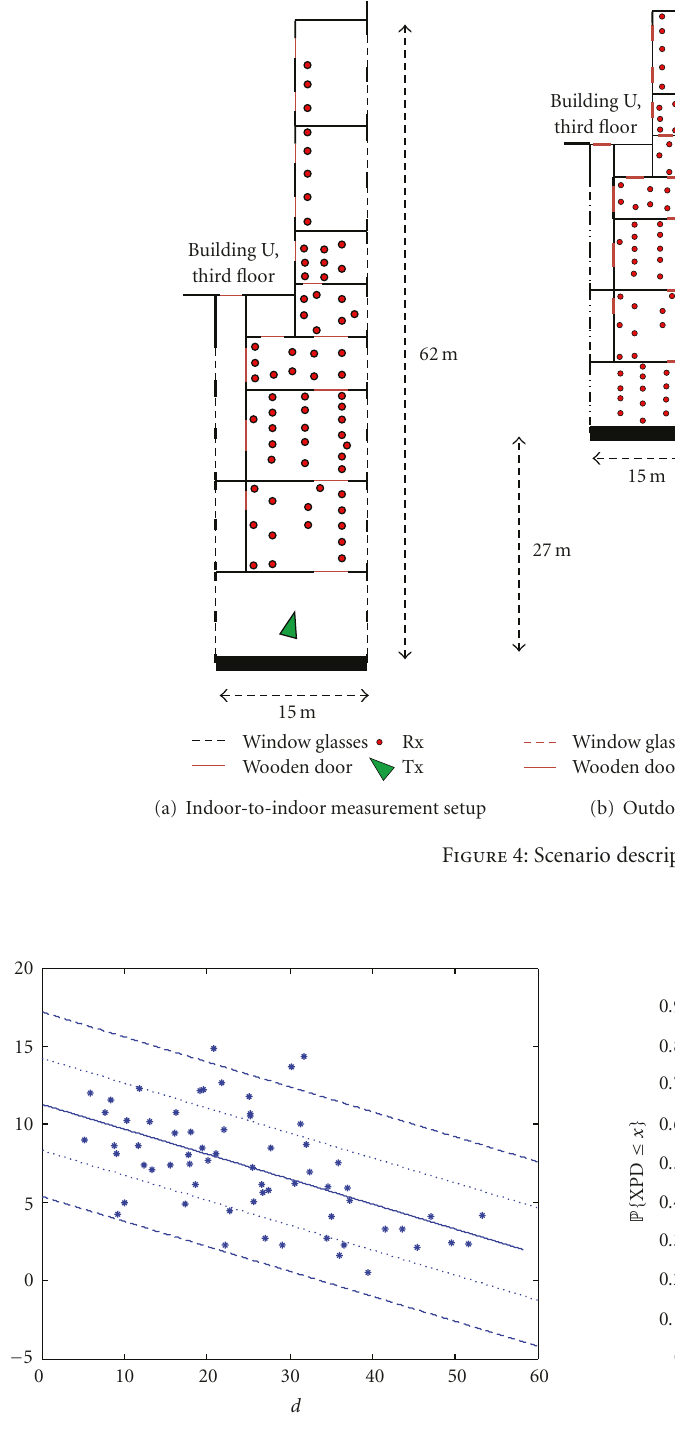
Figure 5: XPD in logarithmic scale, as a function of the Tx distance, in the indoor-to-indoor scenario with an initial horizontal polarization.